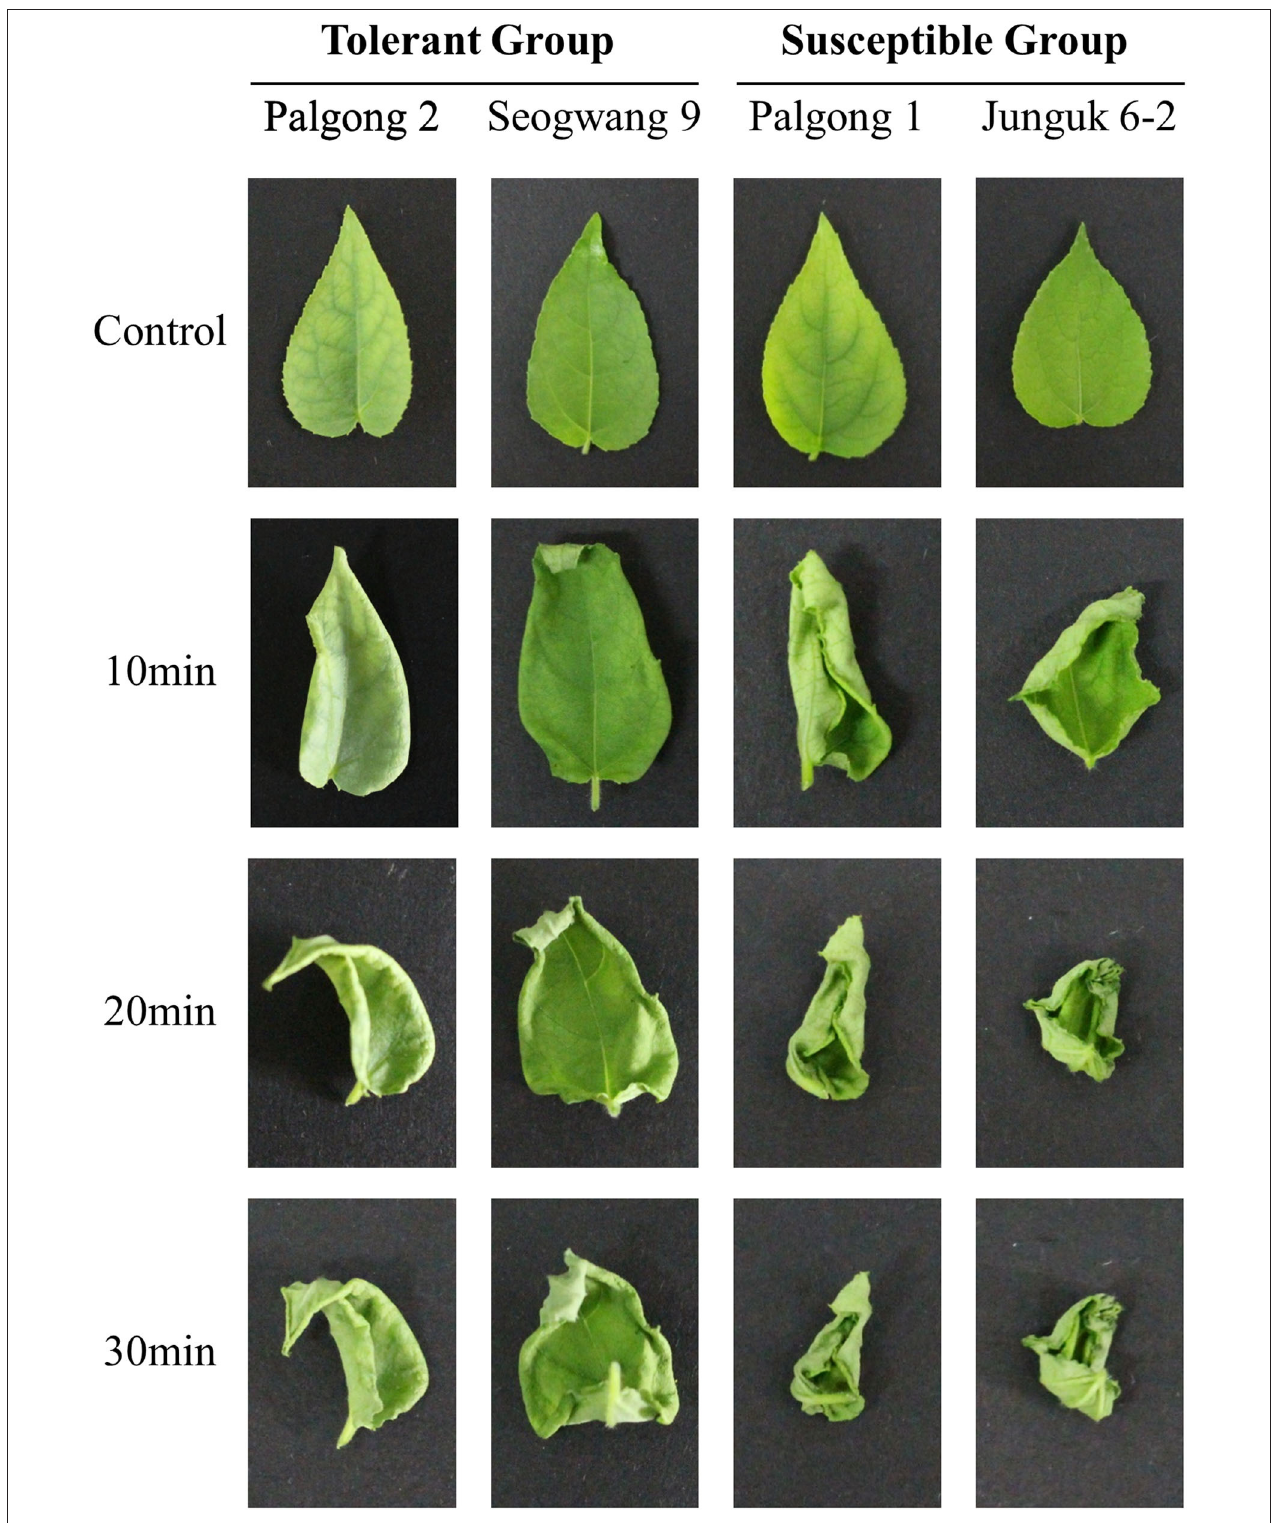
FIGURE 1 | The response of drought-resistant and susceptible Populus davidiana cultivars to dehydration. The leaves were detached and allowed to sit for 30min at room temperature. The leaves of Palgong 1 and Junguk 6–2 showed severe curling and rolling which is a characteristic of moisture stress after 10, 20, and 30min as compared with the leaves of Palgong 2 and Seogwang 9, proving the significantly tolerant response of Palgong 2 and Seogwang 9 to dehydration. “Control” leaves were detached and pictures were taken immediately without the stress treatment.